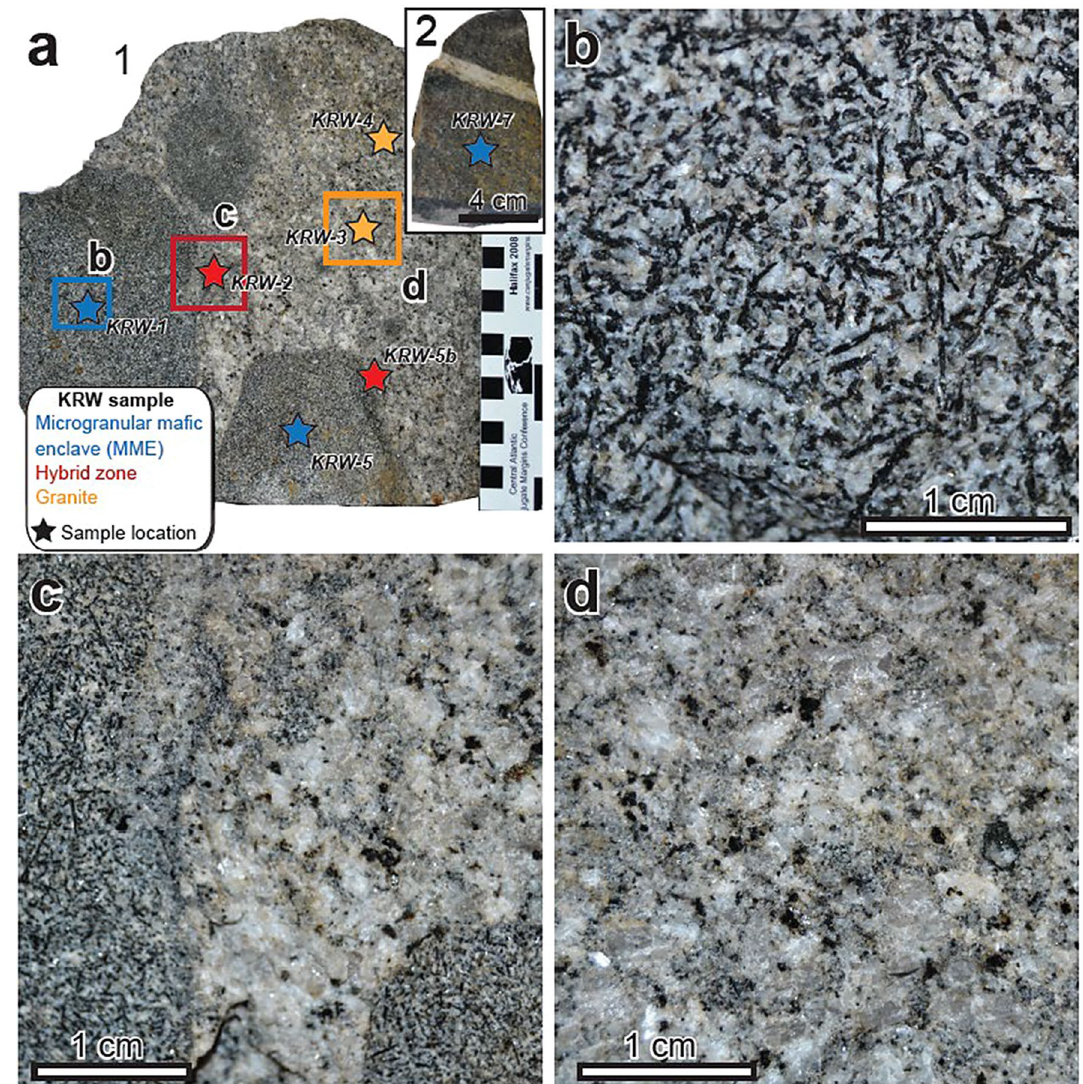
Figure 3. ( a ) Photographs of a sample KRW that includes both felsic and mafic components and an MME (2: inset in a ) that were analyzed in detail at Granada University. The scale in ( a ) is cm. The sampling site is shown as KRW3 in Supplementary Fig. S1. Photographs ( b – d ) are magnified images for subsamples KWR-1, KWR-2, and KWR-3, respectively. Subsamples KWR-4, -5, -5b, and -7 are also shown as stars in ( a ). Photos were taken by Aitor